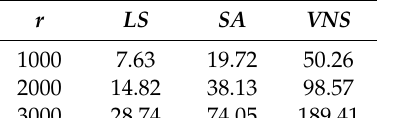
Table 3. Average operation time (s).